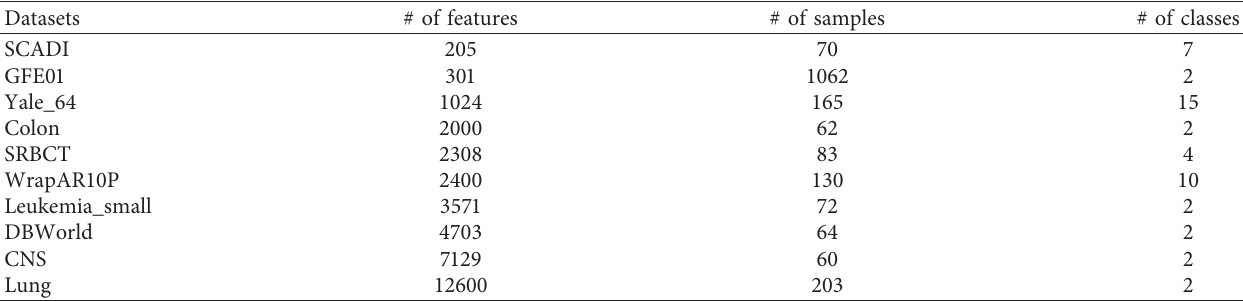
Table 1: Basic information for the test